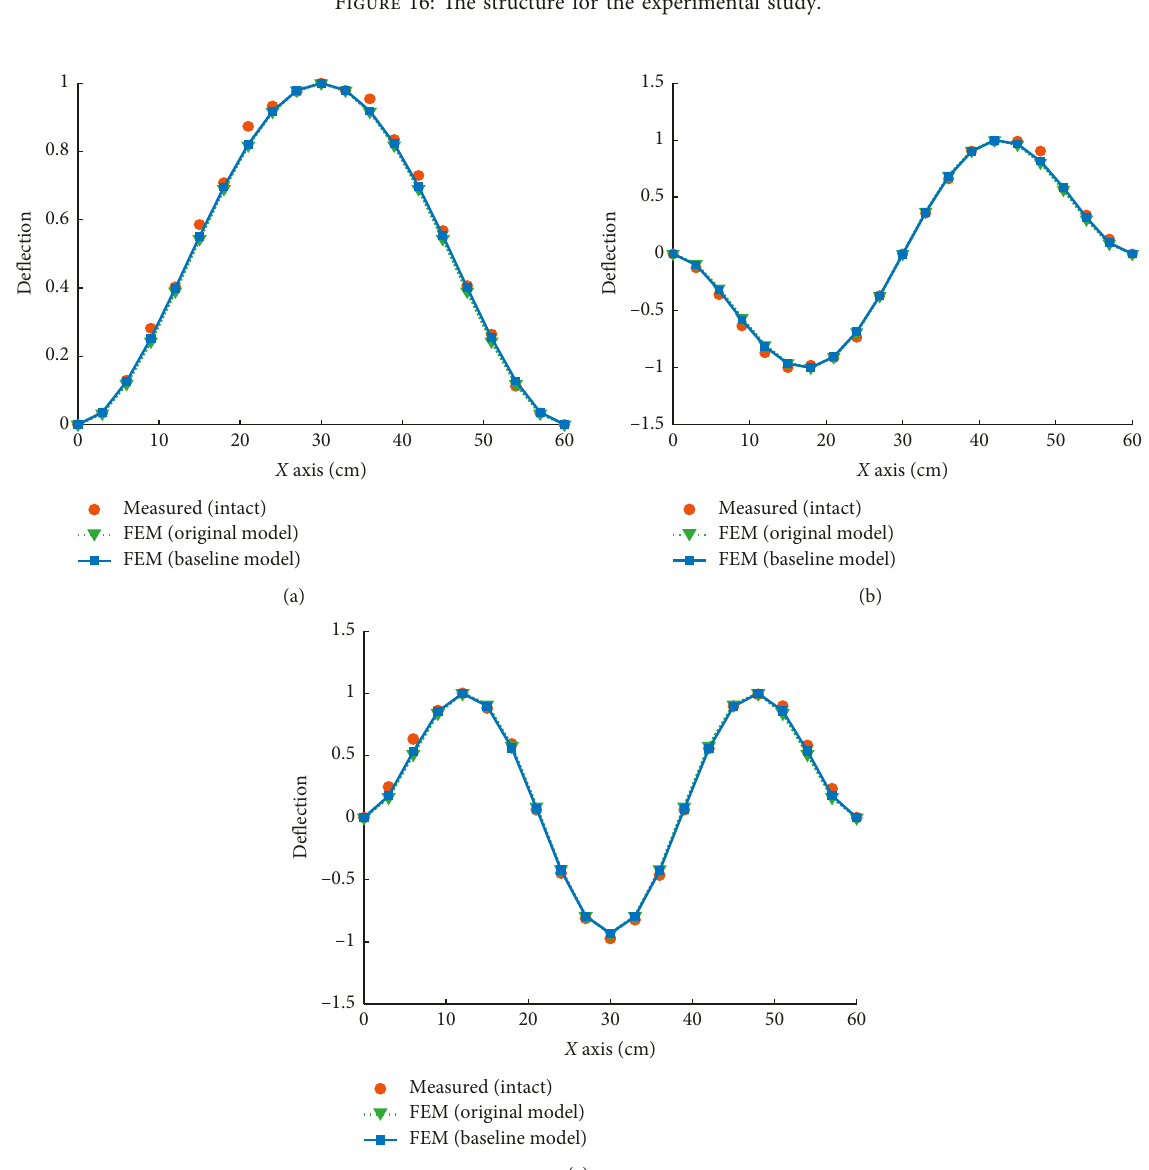
Figure 17: Modal shapes of the undamaged beam of (a) the first modal, (b) the second modal, and (c) the third